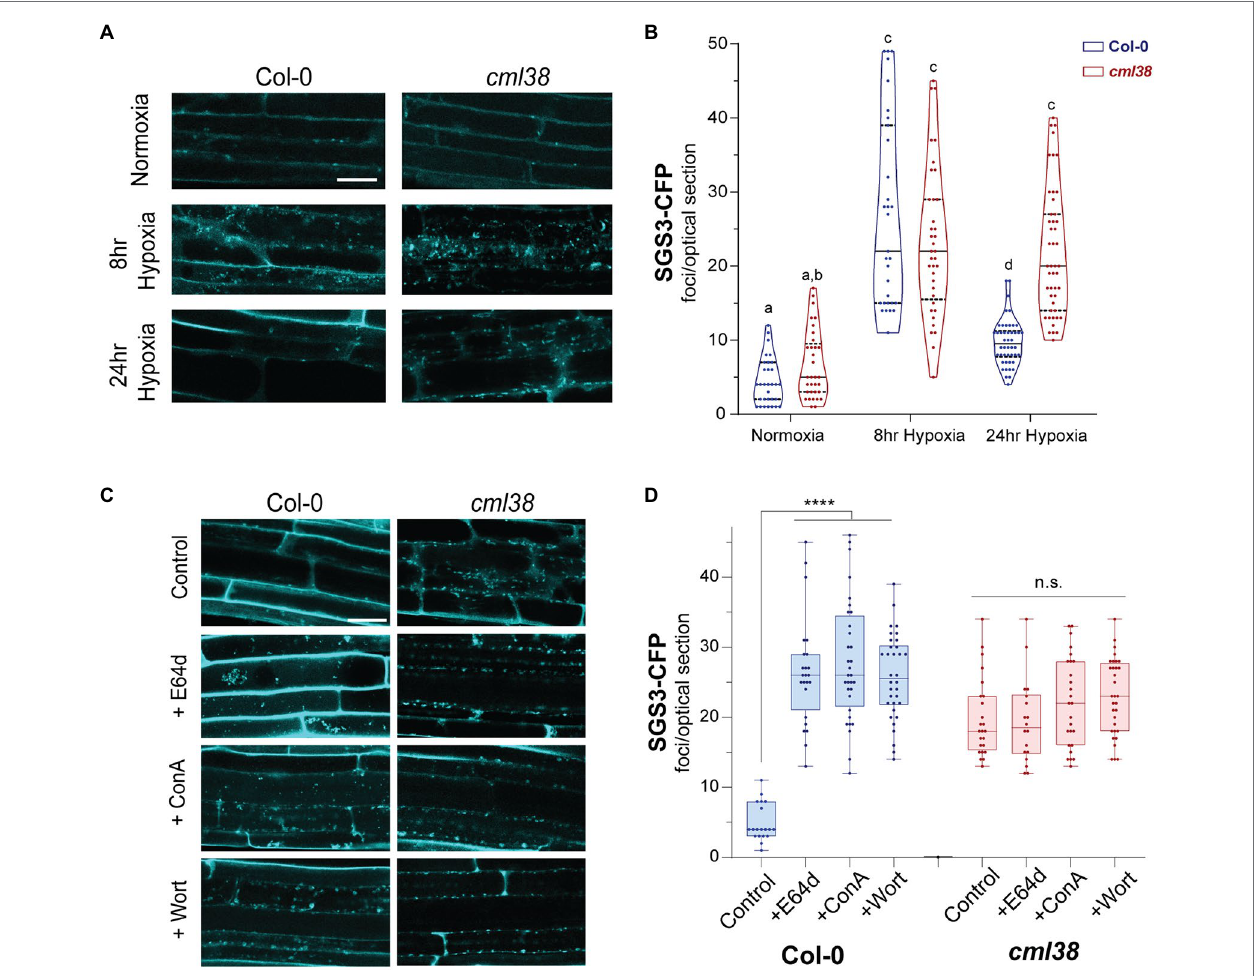
FIGURE 4 | SGS3 requires CML38 and the autophagy pathway to be degraded during hypoxia. (A) Representative confocal micrographs of A. thaliana root epidermal cells in SGS3-CFP Col-0 and cml38 transgenic plants challenged with hypoxia as described in the Materials and Methods. (B) Violin plot of quantitation of SGS3-CFP foci from (A) . Each data point represents a 2 μ m optical section from a single cell. Different letters represent statistically significant differences, assessed by one-way ANOVA analysis. (C) Representative confocal micrographs of SGS3-CFP A. thaliana Col-0 and cml38 transgenic plants at 24 h hypoxia or 24 h hypoxia with the indicated autophagy inhibitors. (D) Quantitative analysis of SGS3-CFP foci from (C) as a box and whisker plot. Each data point represents a 2 μ m optical section from a single cell. Statistical significance was assessed by one-way ANOVA analysis. ****, p < 0.0001; n.s., not significant. For (A,C) , all micrographs are the same scale, and the scale bar is 25 μ